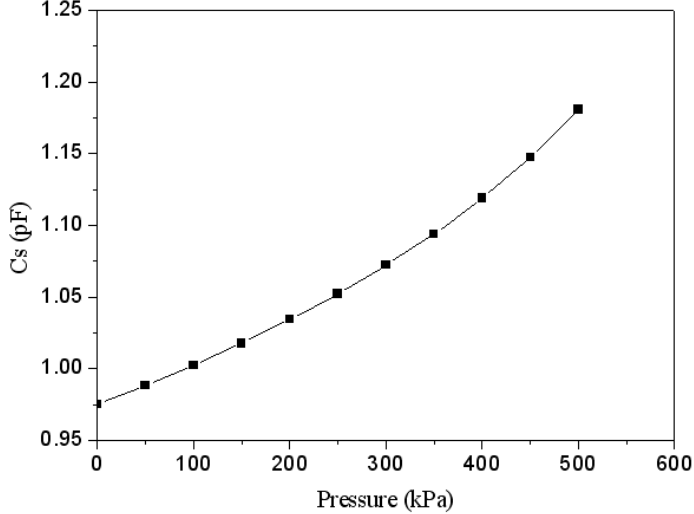
Figure 3. Relation between capacitance and pressure in the pressure